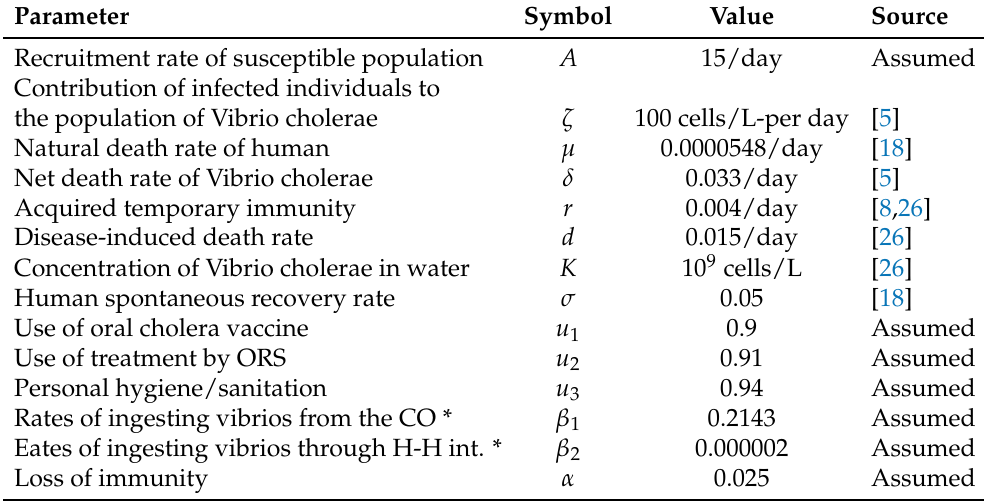
Table 4. Table showing numerical values of parameters used in the